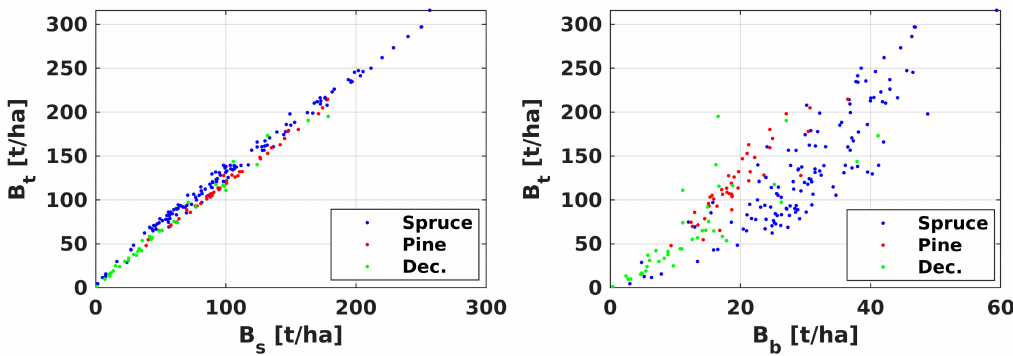
Figure 3. Relationship between stem and above-ground biomass ( left ) and branch and above-ground biomass ( right ) for spruce, pine, and deciduous forests in